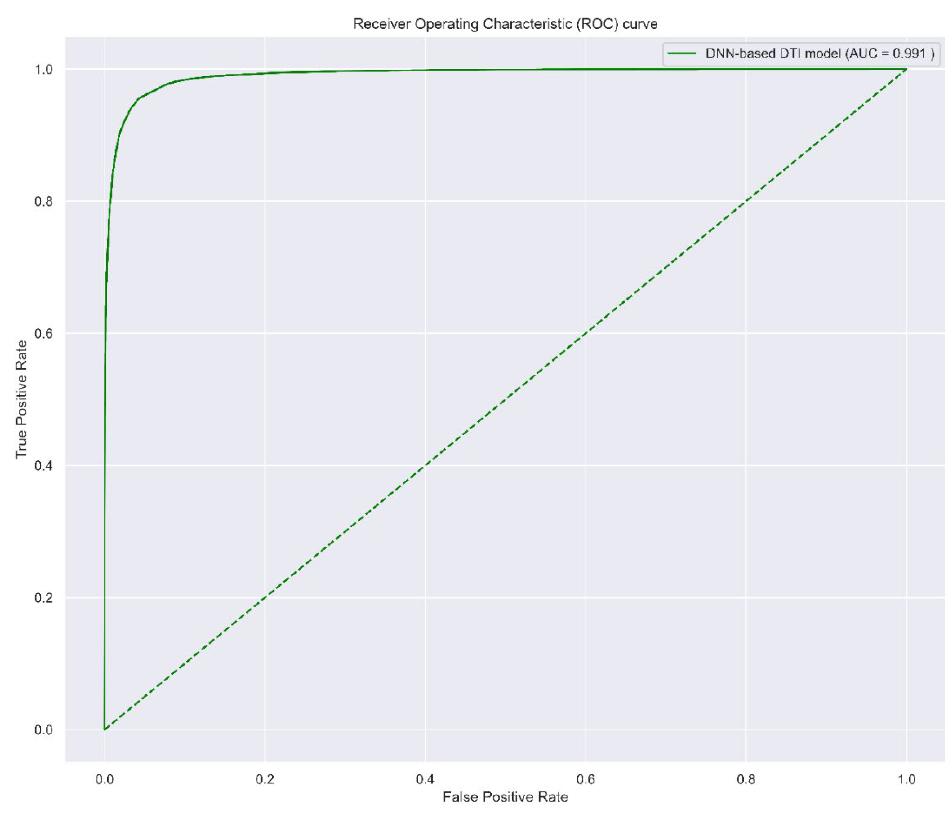
Figure 6. The ROC curve of DNN-based DTI model. The higher AUC value indicates the higher ability to distinguish positive and negative interaction. The worst case (AUC = 0.5) is shown with the dotted line, which implies the model predicts the positive and negative randomly.